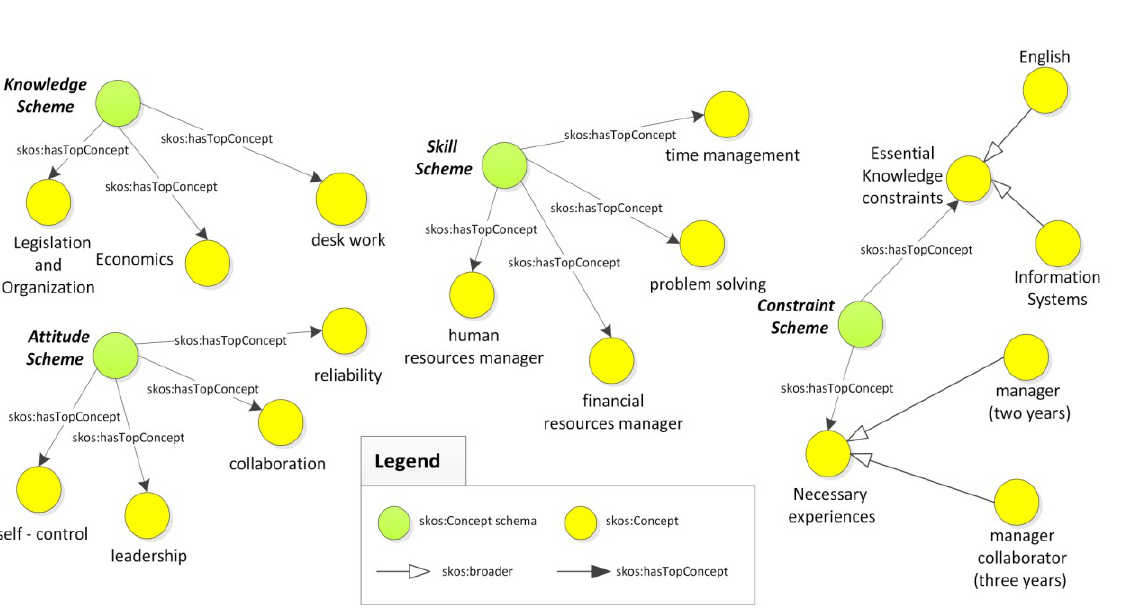
Figure 4. A portion of the ideal KSA profile for the administration manager